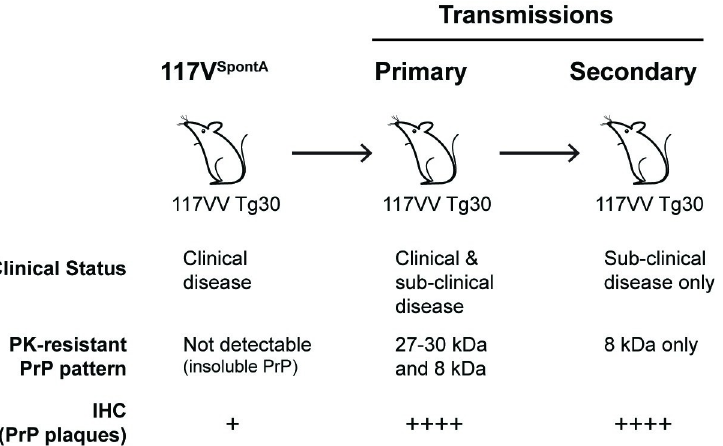
Fig 7. Summary of serial transmission of Spont A mouse brain in further 117VV Tg30 mice. Spont A mouse had clinical prion disease and was culled at 476 days old; focal PrP plaques were found in the anterior commissure of brain, and insoluble PrP aggregates were found in brain homogenate that was not resistant to PK digestion under standard conditions. Primary transmission of Spont A mouse brain to further 117VV Tg30 mice resulted in both clinical neurological and subclinical infection; extensive PrP plaque deposition was found throughout the brain and brain homogenate showed the propagation of distinct abnormal PrP assemblies generating either 27 to 30 kDa or 8 kDa PK- resistant PrP fragments. After secondary transmission in 117VV Tg30 mice extensive PrP plaque deposition throughout the brain was maintained together with the detection of the abnormal PrP assembly generating the 8 kDa PK-resistant PrP fragment; however, all mice remained subclinically affected. IHC, immunohistochemistry; PK, proteinase K; PrP, prion protein.